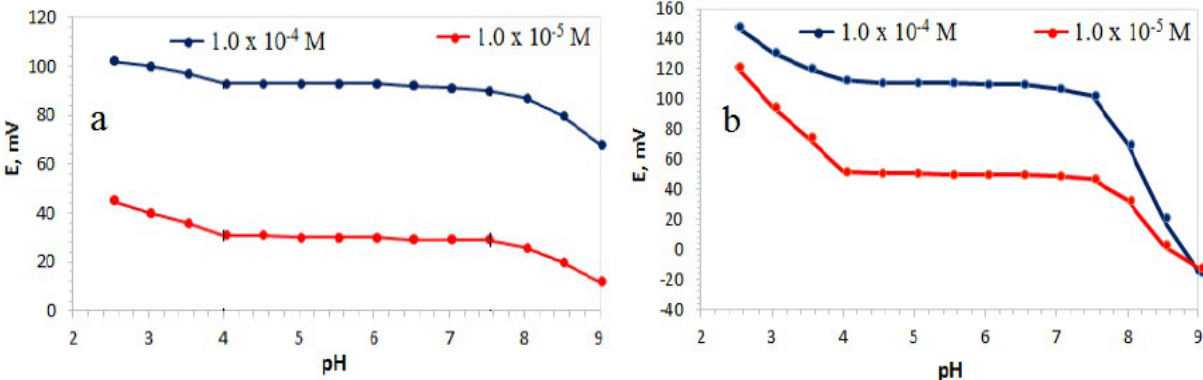
Fig. 5. Effect of pH of the test solution on the potential response of a) ATM-TPB and b)